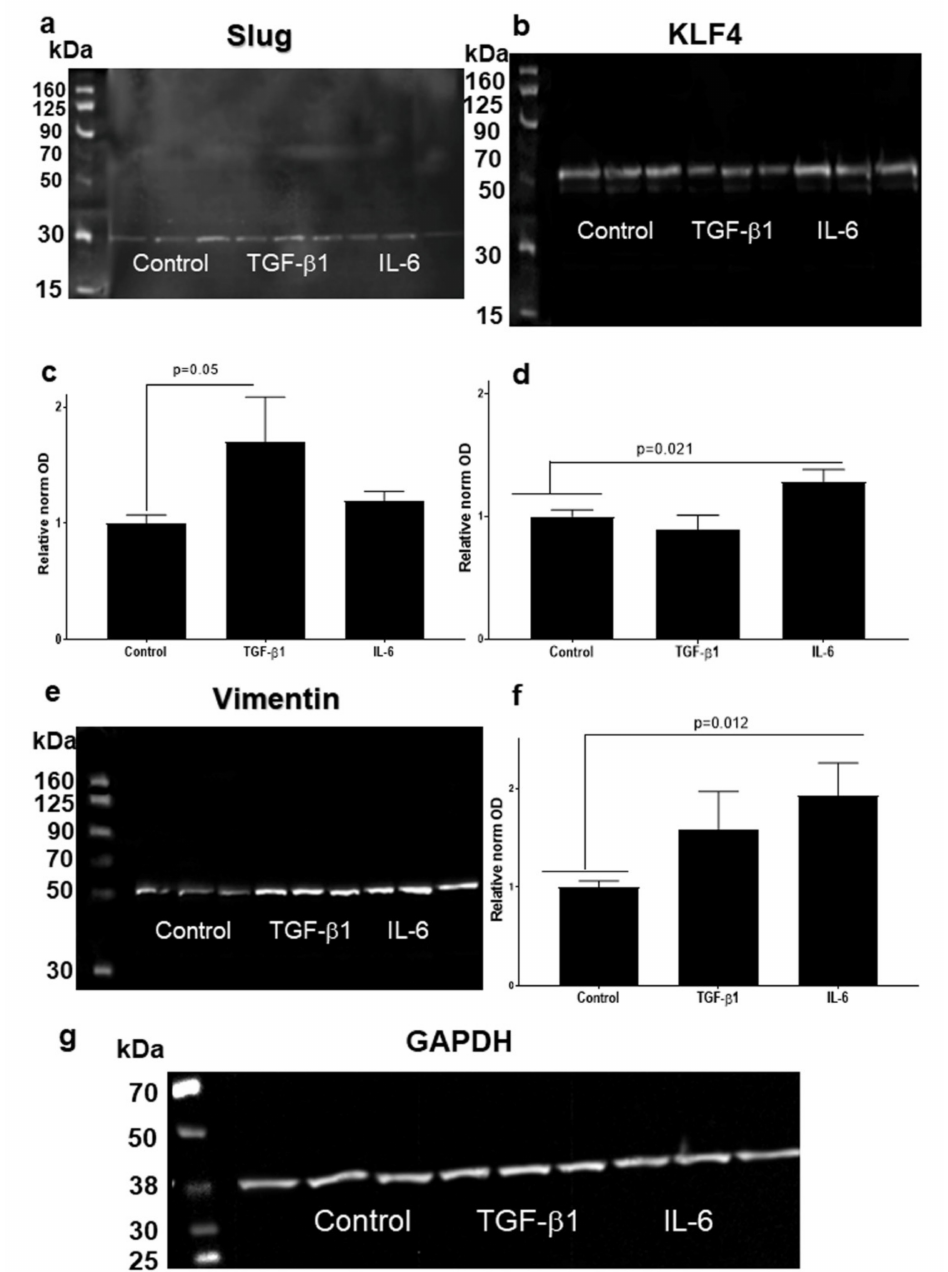
Figure 8. Representative western blots of Slug ( a ), KLF4 ( b ) and vimentin ( e ) proteins in UPCI-SCC-90 cells in control, 1 ng/mL TGF- β 1 and in 50 ng/mL IL-6 treated conditions. TGF- β 1 induced a moder- ate but significant increase ( p = 0.0499, by Mann Whitney test compared to control) in Slug protein level. Il-6 did not statistically upregulated Slug in UPCI- SCC-90 cells ( a , c ). KLF4 was not regulated by TGF β 1, but it was upregulated by IL-6 ( p = 0.021 by Student’s t -test compared to control) ( b , d ). TGF- β 1 upregulated vimentin at protein levels, but it was not statistically significant. IL-6 induced significant upregulation of vimentin ( p = 0.012 by Student’s t -test compared to control) ( e , f ). Four western blot membranes were acquired digitally, and the band optical densities (ODs) of proteins of interest and of loading control (GAPDH) were measured using the Image Studio Lite of Li-cor. The ODs of proteins of interest were normalized to loading control. Mean normalized optical densities of control samples were set to “1”, and this control mean was used as reference ( c , d , f ). Loading control by western blot membrane reacted with GAPDH antibody is presented on panel ( g